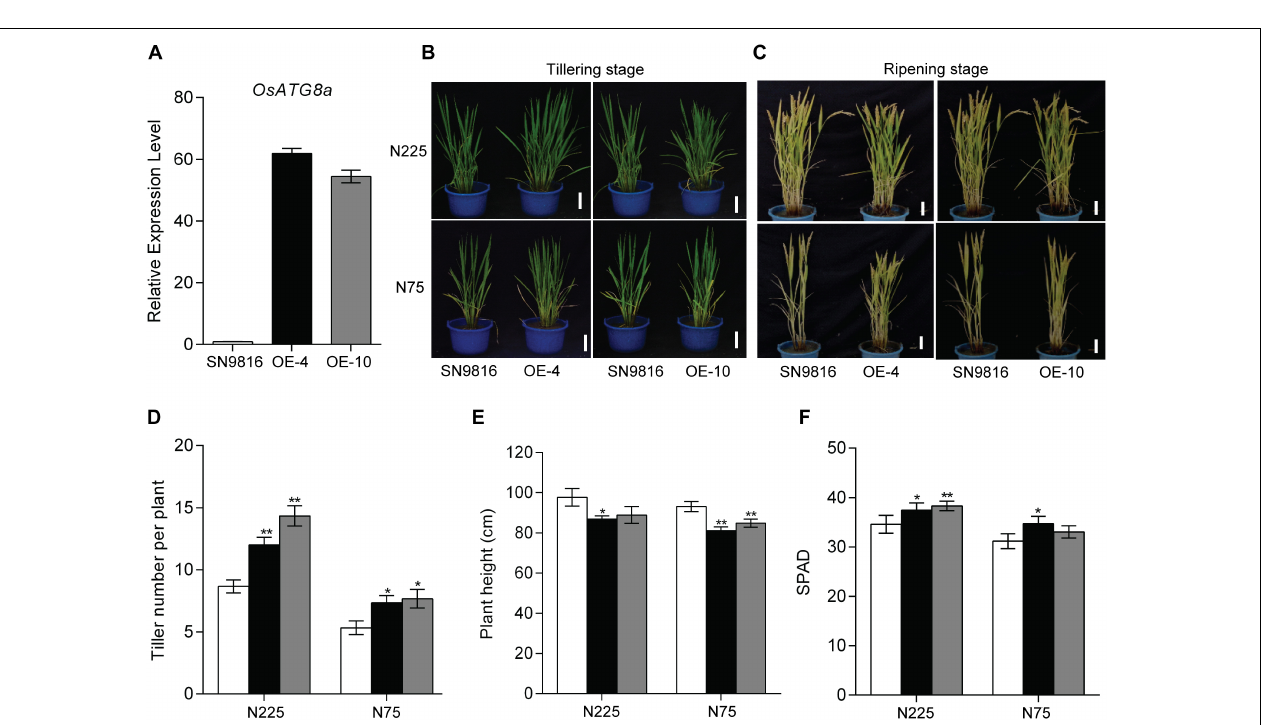
FIGURE 2 | Characterization of OsATG8a -overexpressing transgenic rice. (A) Expression level of OsATG8a in 14-day-old seedlings of SN9816 and transgenic lines (OE-4 and OE-10). OsActin1 was used as an internal control. Values are means ± SD ( n = 3). Phenotypes of the whole rice plants under sufficient N (N225) or low N (N75) conditions at tillering stage (B) and ripening stage (C) . Scale bars, 10 cm. (D) Tiller number per plant, (E) plant height per plant and (F) SPAD value per plant of SN9816 and OsATG8a -overexpressing lines (OE-4 and OE-10) under N225 or N75 conditions at ripening stage. Values are means ± SD of one representative biological replicate ( n = 12) out of three, ∗ P < 0.05, ∗∗ P < 0.01 ( t